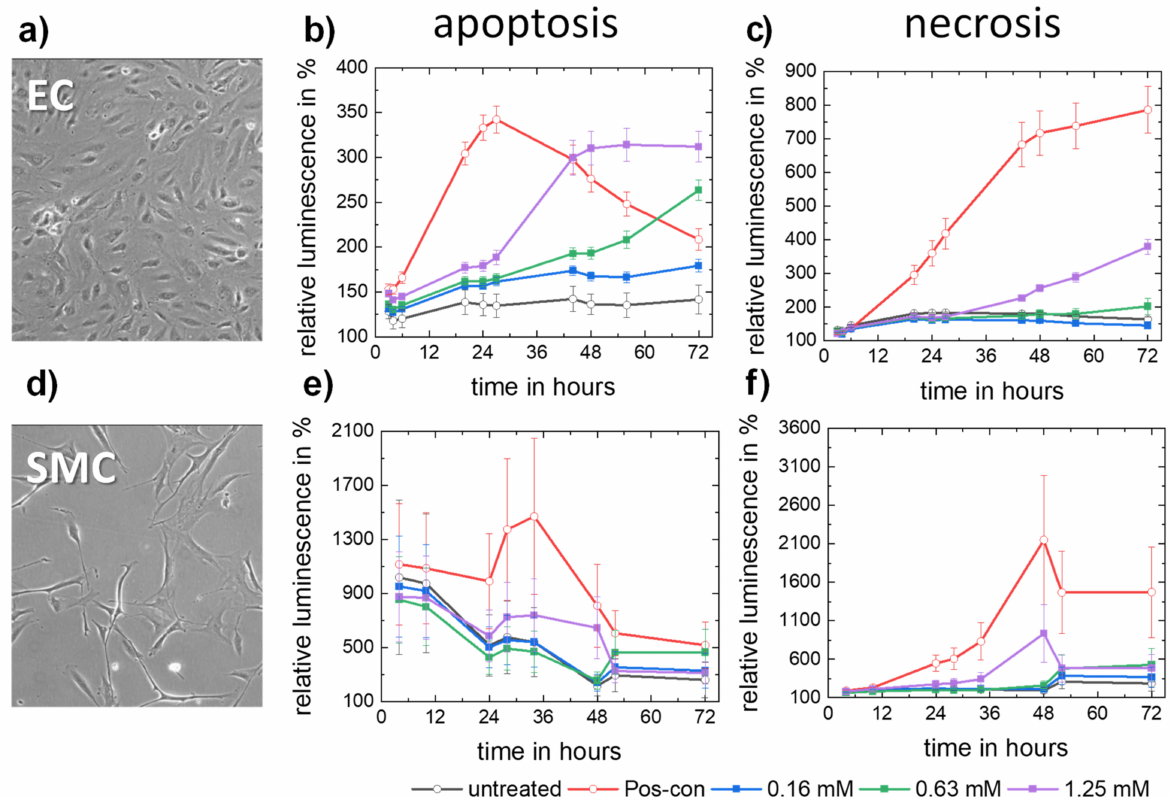
Figure 5. Apoptosis and necrosis of HCAECs and HCASMCs after incubation with Mo ion-containing cell media. HCAEC (( a ), Brightfield microscopy) showed a three-fold increased apoptotic rate after 48 h incubation with the highest Mo concentration ( b ) while necrosis was first enhanced at 44 h ( c ). In HCASMC (( d ), Brightfield microscopy) apoptosis is slightly enhanced after 34 h at the highest Mo concentration ( e ) while a slightly but non-significantly enhanced necrotic rate was only observed at 48 h at the highest Mo concentration ( f ). n =